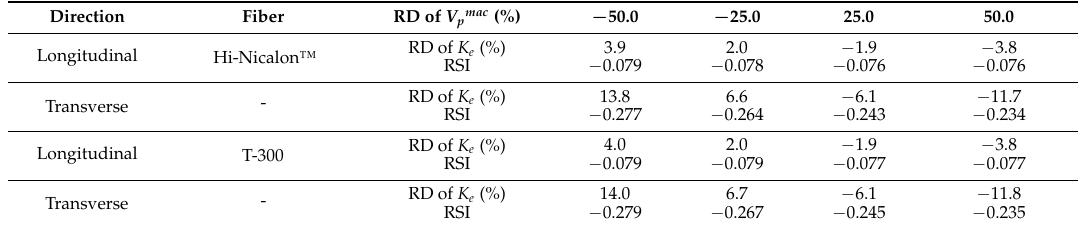
Table 10. Sensitivity analysis of macro-porosity for 2D composites.